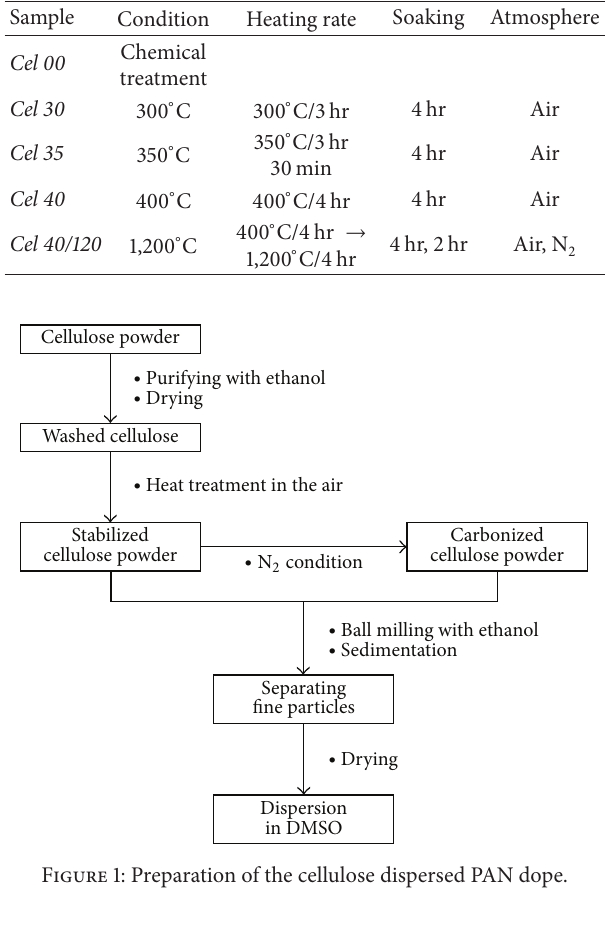
Table 1: Heat treatment conditions of the cellulose particles.